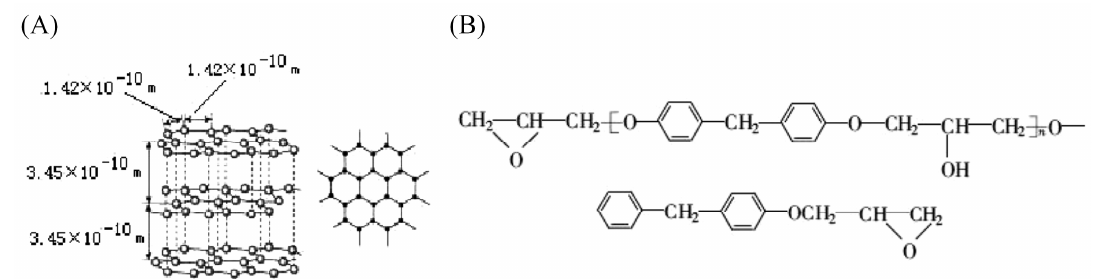
Figure 4. Microstructure of carbon fiber and epoxy resin: ( A ) microstructure of carbon fiber; ( B ) main structure of epoxy resin [38].